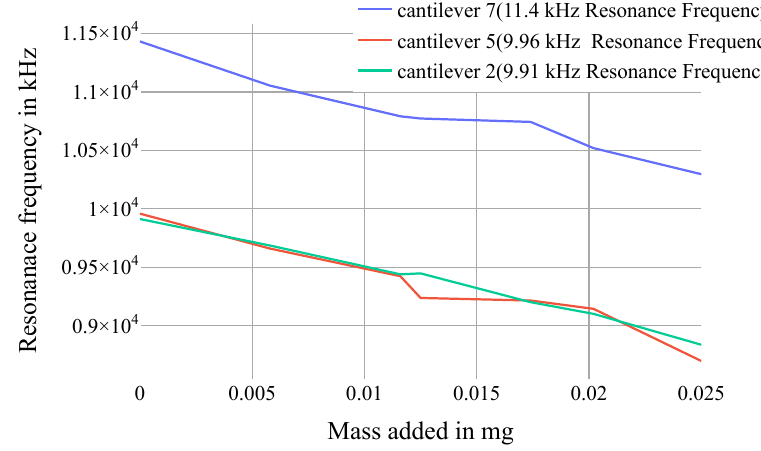
Figure 11. Change in resonance frequency with mass added to three different cantilevers.